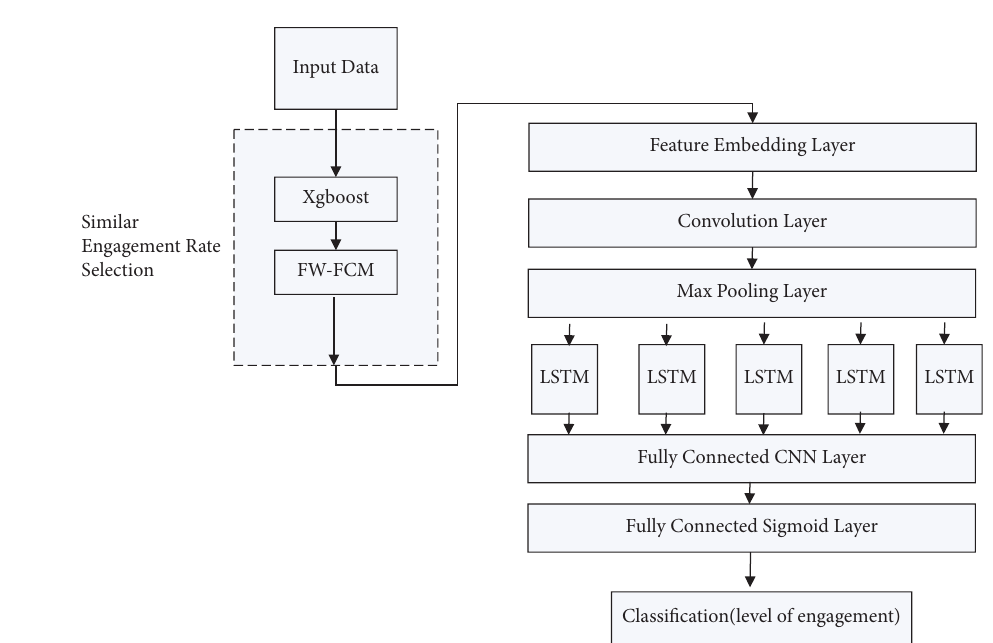
Figure 4: The flowchart of the FW-CNN-LSTM